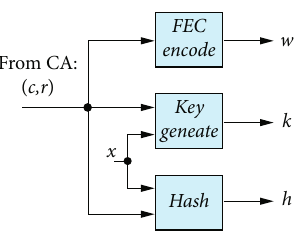
Figure 4: The steps used by the server to obtain helper data w ,